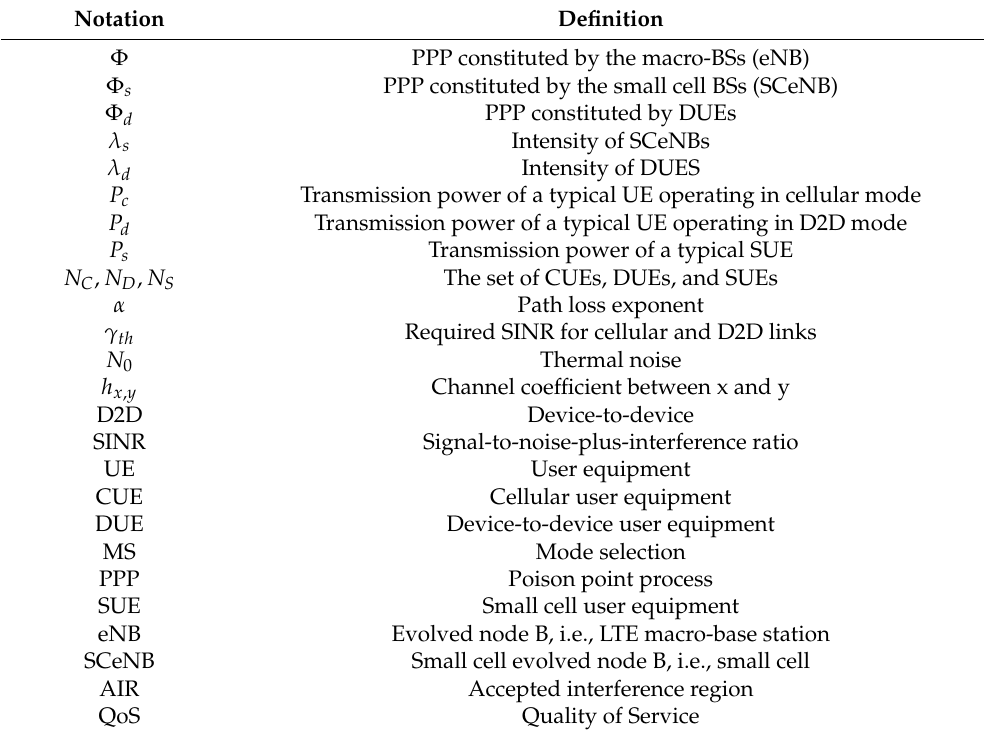
Table 1. List of key notations and abbreviations